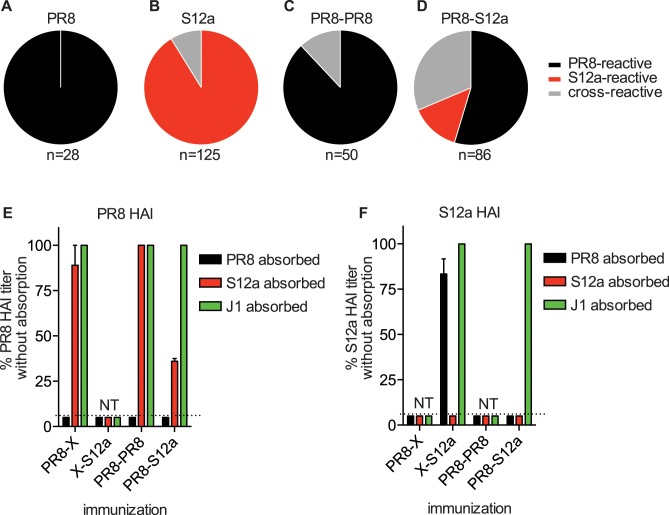
PR8-S12a sequential exposure elicits many Abs with a classical OAS phenotype.(A, B) Mice were immunized i.v. with 1000 HAU of PR8 (A) or S12a (B) virus. Hybridomas were created from splenocytes collected 5 days after vaccination. (C, D) Mice were immunized i.p. with 1000 HAU of PR8 and boosted i.v 28 days later with 1000 HAU PR8 (C) or S12a (D). Hybridomas were produced 3 days after the boost. We completed ELISAs with a range of different mAb concentrations using plates coated with PR8, S12a, and J1 (J1 is a virus that has an H3 HA). mAbs were determined to be PR8 and/or S12a-reactive if they produced an ELISA signal that was 4 times greater using PR8 or S12a coated plates compared to plates coated with the J1 negative control. Mice boosted with S12a had a higher proportion of Abs cross-reactive for both PR8 and S12a (p < 0.005; Fisher’s exact test). (E,F) HAI assays were completed with sera that were pre-incubated with MDCK cells infected with PR8, S12a, or J1 (an H3 negative control). For these experiments, we used sera collected 21 days after the second viral exposure. Data are expressed as % of HAI titer using unabsorbed sera (100% indicates titer was not reduced by absorption). Data are mean +/- SEM; n = 3 mice per group. NT = no titer.